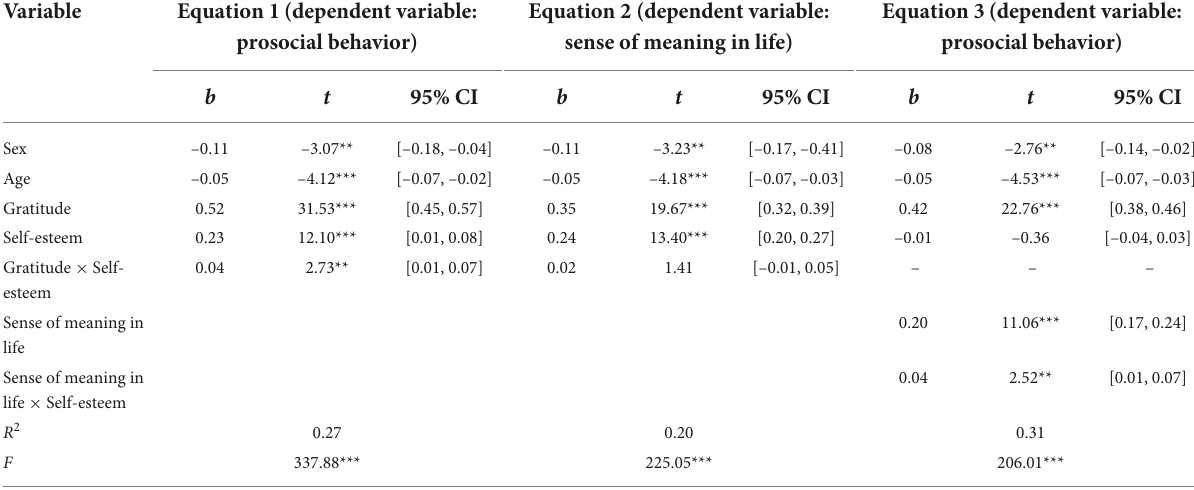
TABLE 2 Test of moderated mediating model of gratitude on pro-juvenile prosociality.